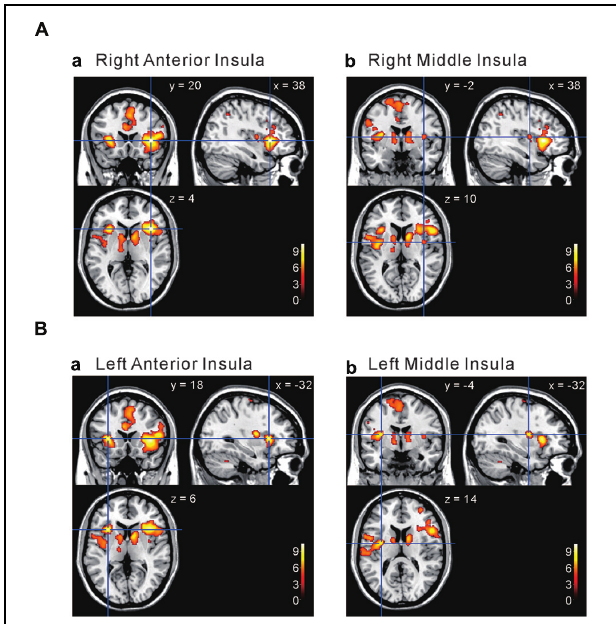
FIGURE 4 | Brain areas significantly activated by the comparison [Capsaicin–NaCl]. (A,B) The anterior and middle insula activated by capsaicin stimuli. ( x, y, z ) values represent Montreal Neurological Institute (MNI) coordinates (mm), and the color bar represents the T -values.